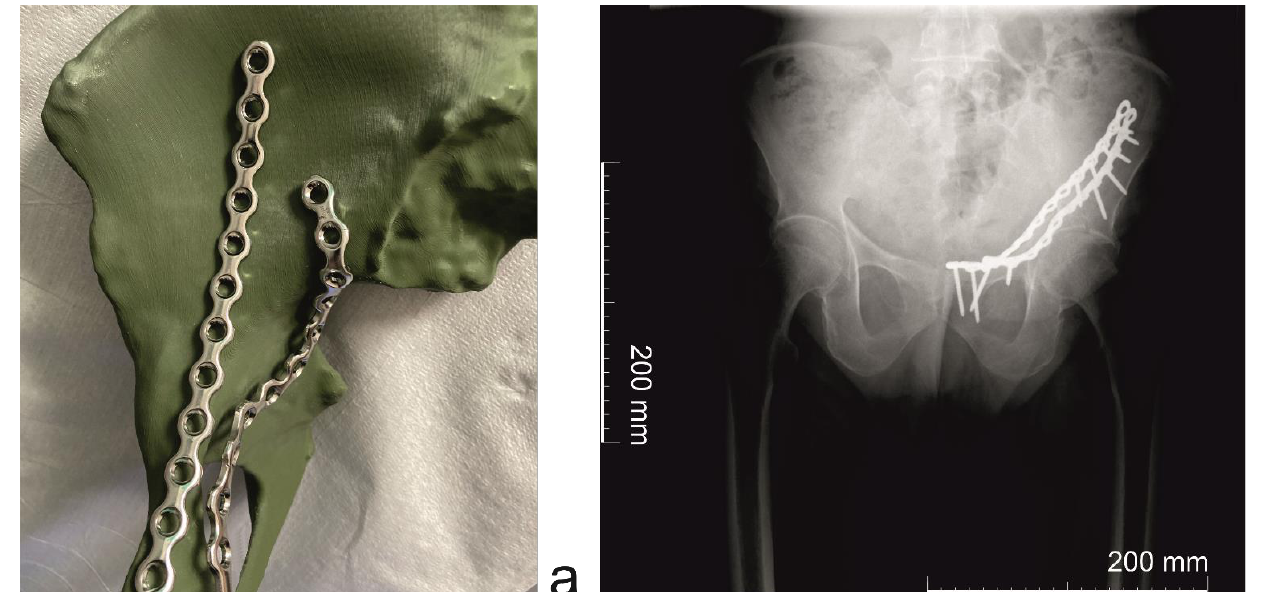
Figure 5. (Patient 3) ( a ) Mirrored uninjured hemipelvis with reconstruction plates ( b ) (Patient 4) Post-operative X-ray image (scale bar = 200 mm). Table 2. CT scan parameters.